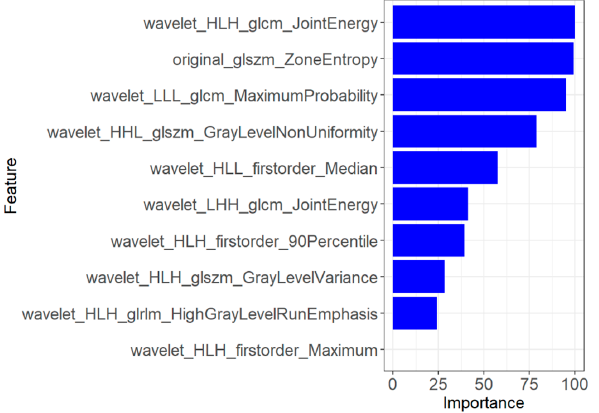
Figure 8. The 10 feature parameters and corresponding coefficients after screening in the first model.